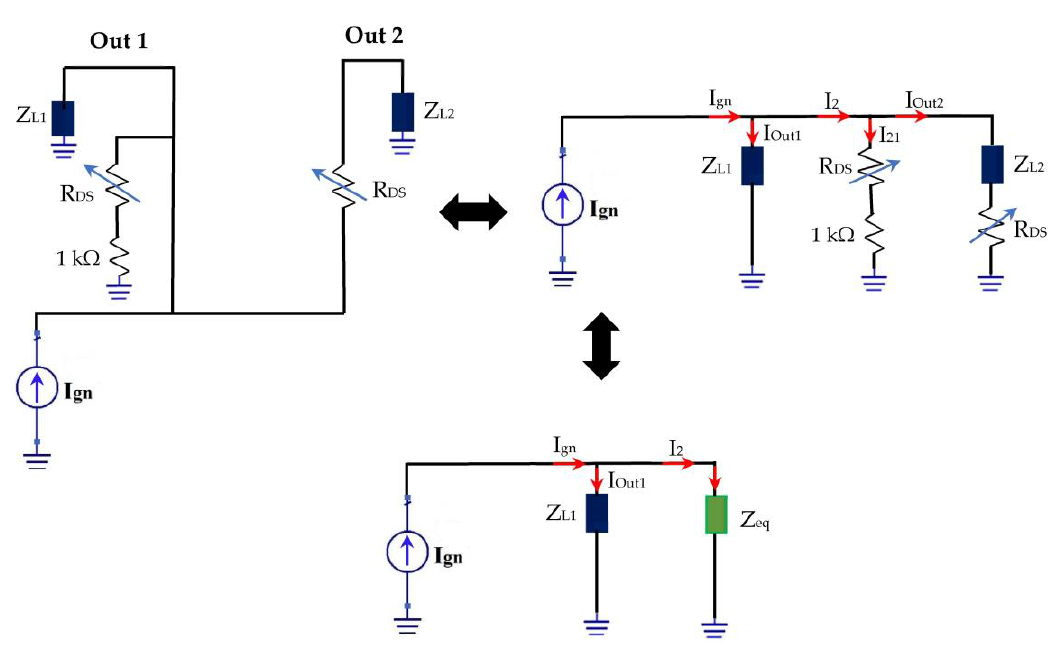
Figure 30. Electrical representation of the proposed switch.